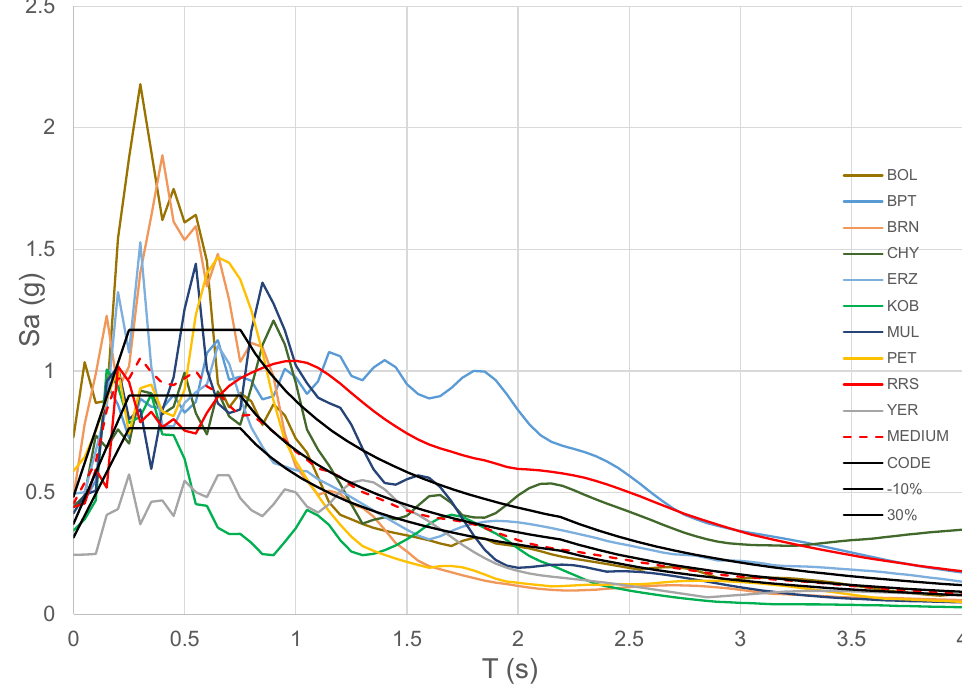
Figure 4. Selected Input motions.